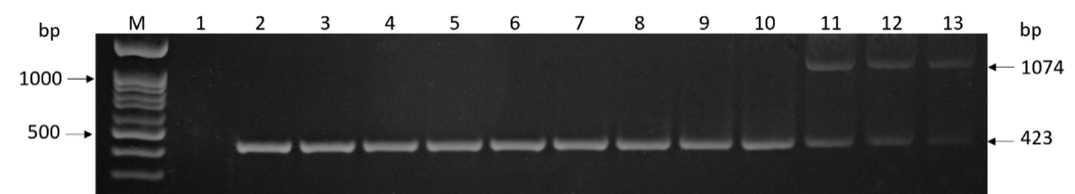
Figure 5. Amplification products obtained by multiplex PCR for the evaluation of transgenic roots. M: DNA Ladder (FastGene 100bp DNA Ladder RTU, NIPPON Genetics Europe GmbH). Lane 1: Roots from non-transformed seedlings, showing absence of both rol2B and virCD genes. Lanes 2, 3, 4: Roots transformed with A. rhizogenes strain R1000 , carrying the rolB2 gene. Lanes 5, 6, 7: Roots